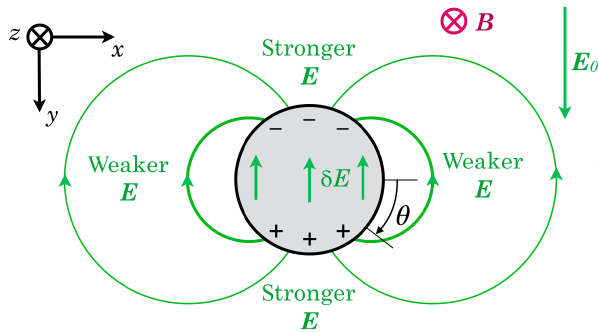
Figure 2. A circular patch of denser plasma will acquire a polari- sation that reduces the electric field strength inside compared to the background field strength. This sets up a cylindrical (2-D) dipole. The + and − show net surface charge. The sense of the angle θ used in the analysis is shown (the conventional sense, but appearing clockwise because ˆ z is into the page). This figure ignores the Hall current, but it is included in our analysis, and it is shown in Fig. 4. The sense of plasma drift around such a feature is sketched in Fig. 3.